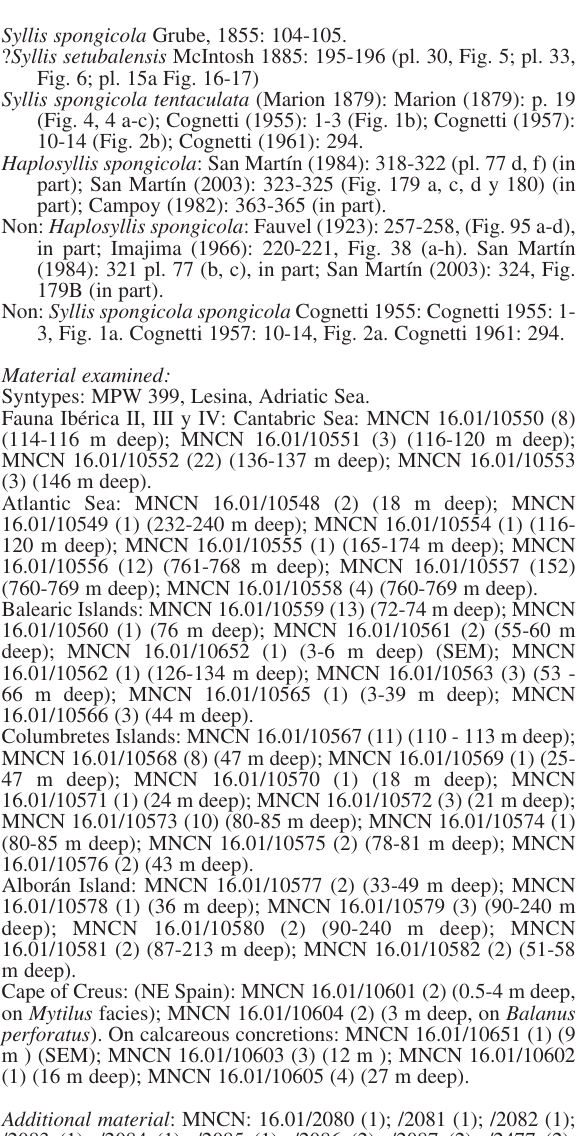
Fig. 6; pl. 15a Fig. 16-17) Syllis spongicola tentaculata (Marion 1879): Marion (1879): p. 19 (Fig. 4, 4 a-c); Cognetti (1955): 1-3 (Fig. 1b); Cognetti (1957): 10-14 (Fig. 2b); Cognetti (1961): 294. Haplosyllis spongicola : San Martín (1984): 318-322 (pl. 77 d, f) (in part); San Martín (2003): 323-325 (Fig. 179 a, c, d y 180) (in part); Campoy (1982): 363-365 (in part). Non: Haplosyllis spongicola : Fauvel (1923): 257-258, (Fig. 95